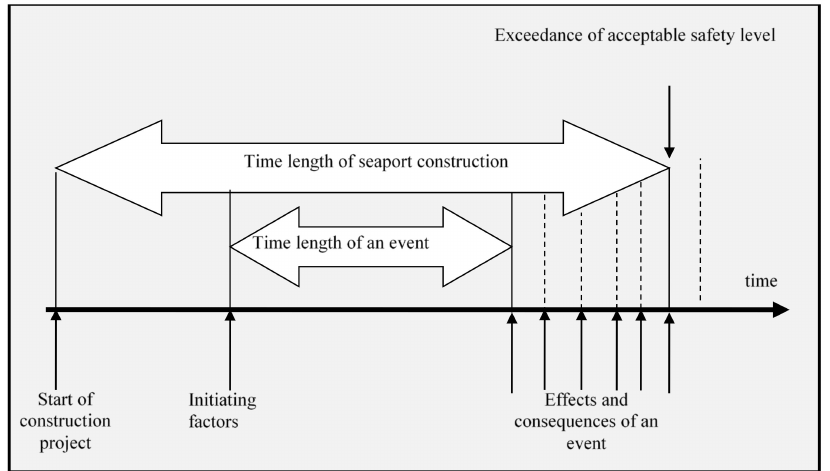
Figure 2. Schematic illustration of an event during a seaport